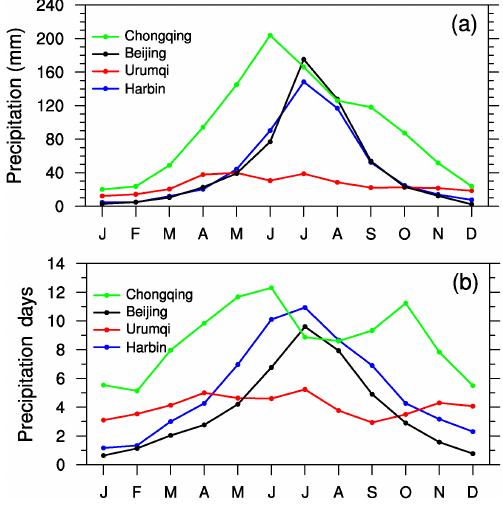
Figure 6. Annual cycle of precipitation (a) and precipitation days (b) of four representative stations (Harbin, Urumqi, Beijing, and